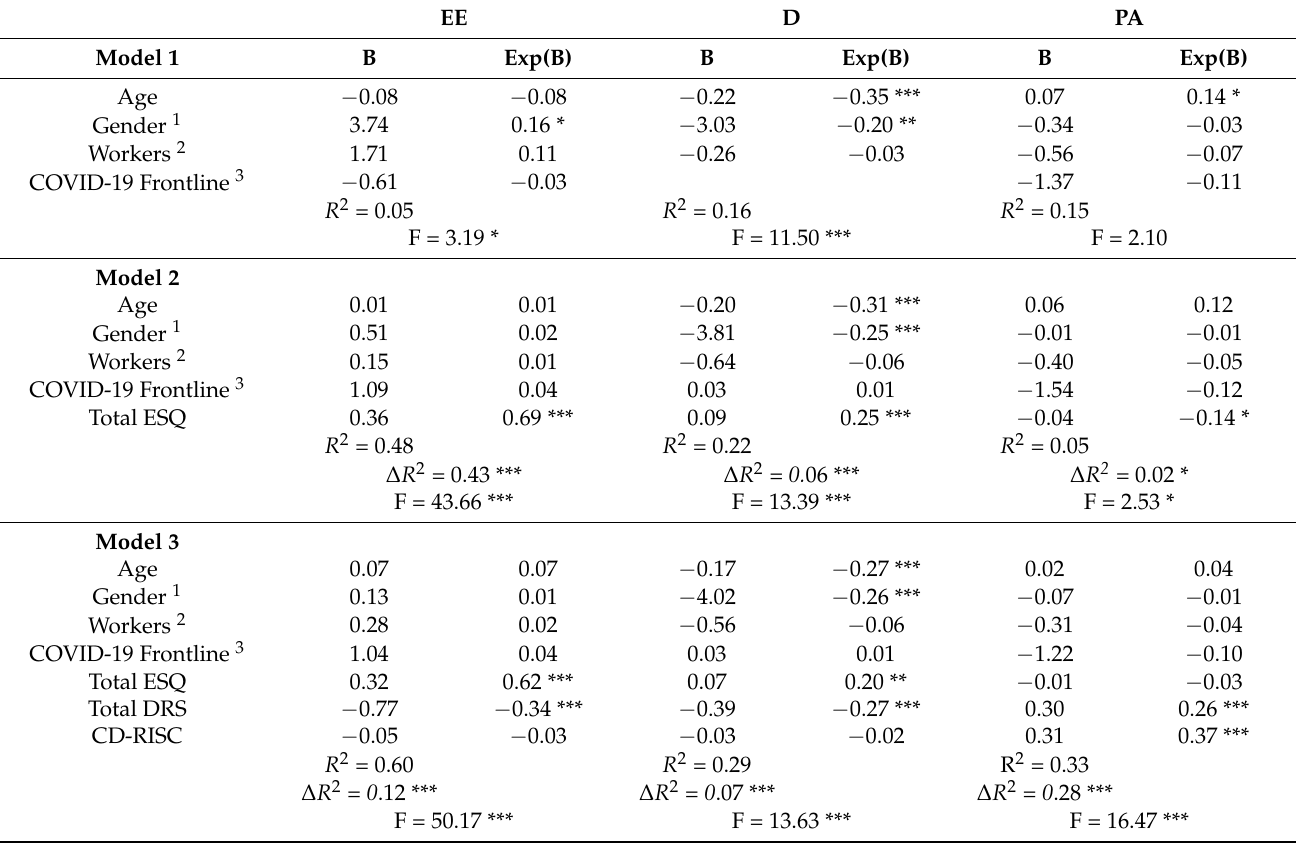
Table 5. Hierarchical linear regression models on MBI—HSS scales ( n = 260).